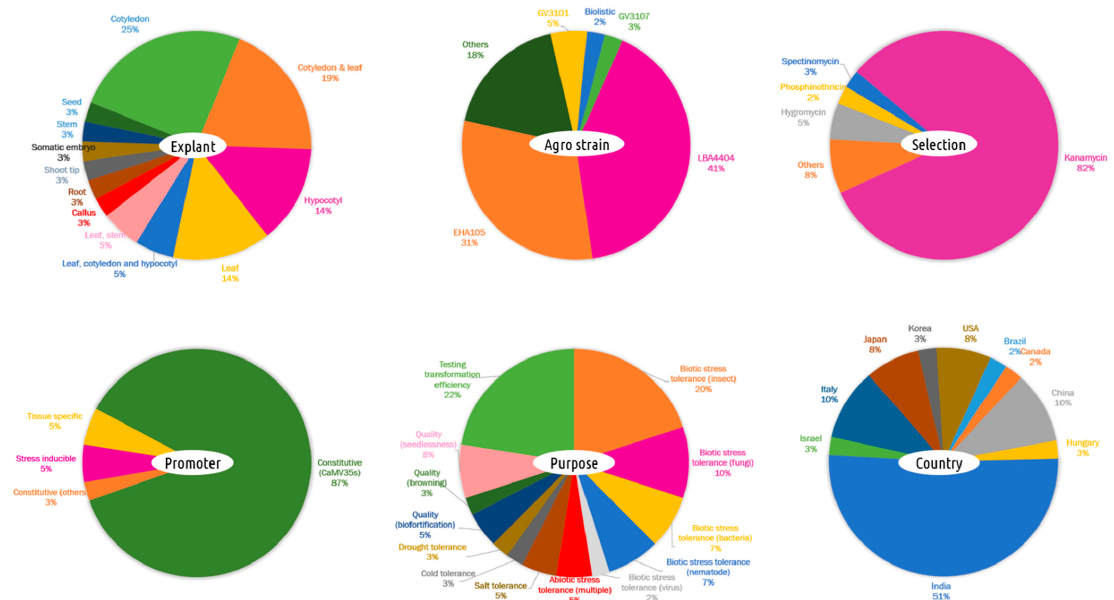
Figure 4. A meta-analysis of literature reports showing the relative contribution of various components of transgenic eggplant. From top left: explant, agrobacterium strains, and selection marker used for transformation. From bottom left: relative percentage of various promoters used, the purpose of transformation, and country-wise contribution of transgenic plant development. Data were retrieved by a manual search of the Scopus and PubMed database (up to early 2021). The journal articles only reported stable development of transgenic eggplant were considered in this analysis.